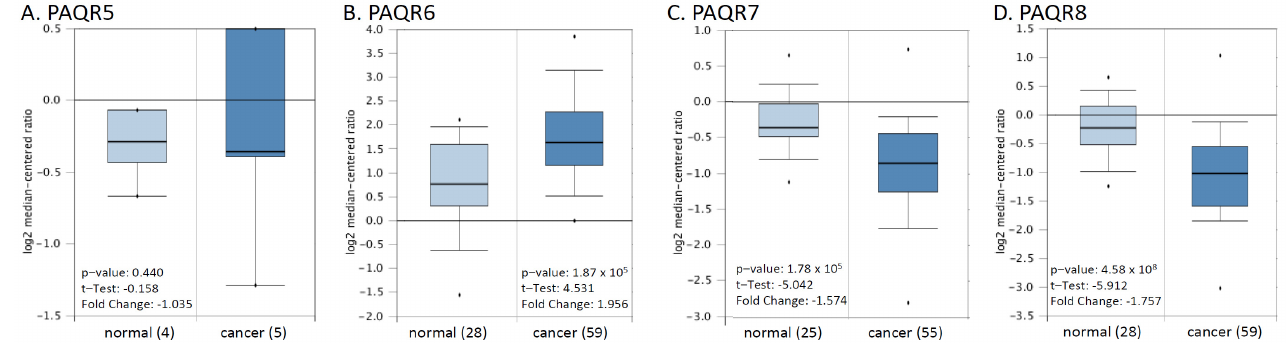
Figure 3. ( A – D ) Microarray analysis of PAQR genes in prostate cancers. Expression of PAGR genes was analyzed using the cDNA microarray dataset derived from a previous report [22]. The data figures were generated on the Oncomine platform.